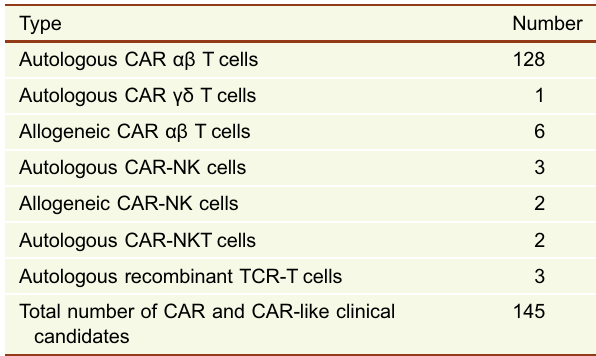
Table 12. Chimeric antigen receptor (CAR)- and T-cell receptor (TCR)- based immuno-oncology clinical